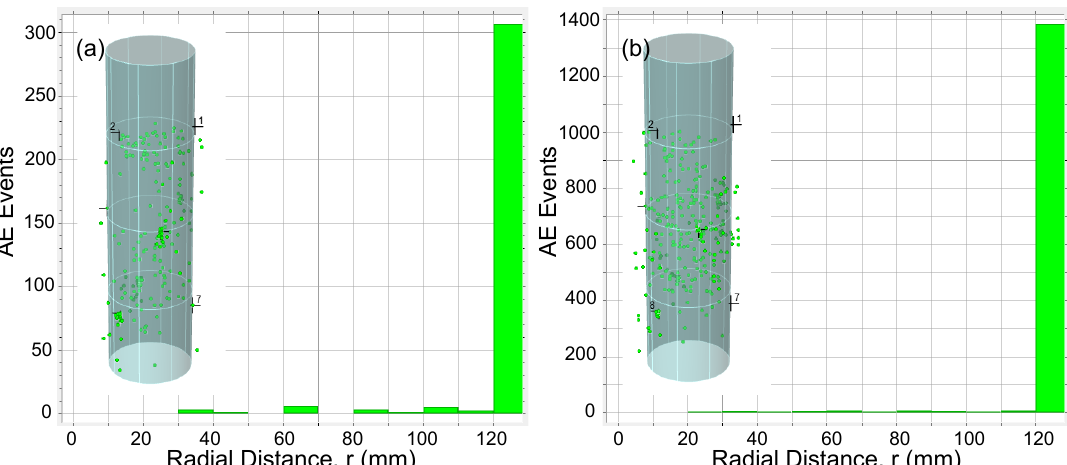
Figure 16. AE events along specimen F12S100L cross section for ( a ) t < 750s and ( b ) 750 ≤ t ≤